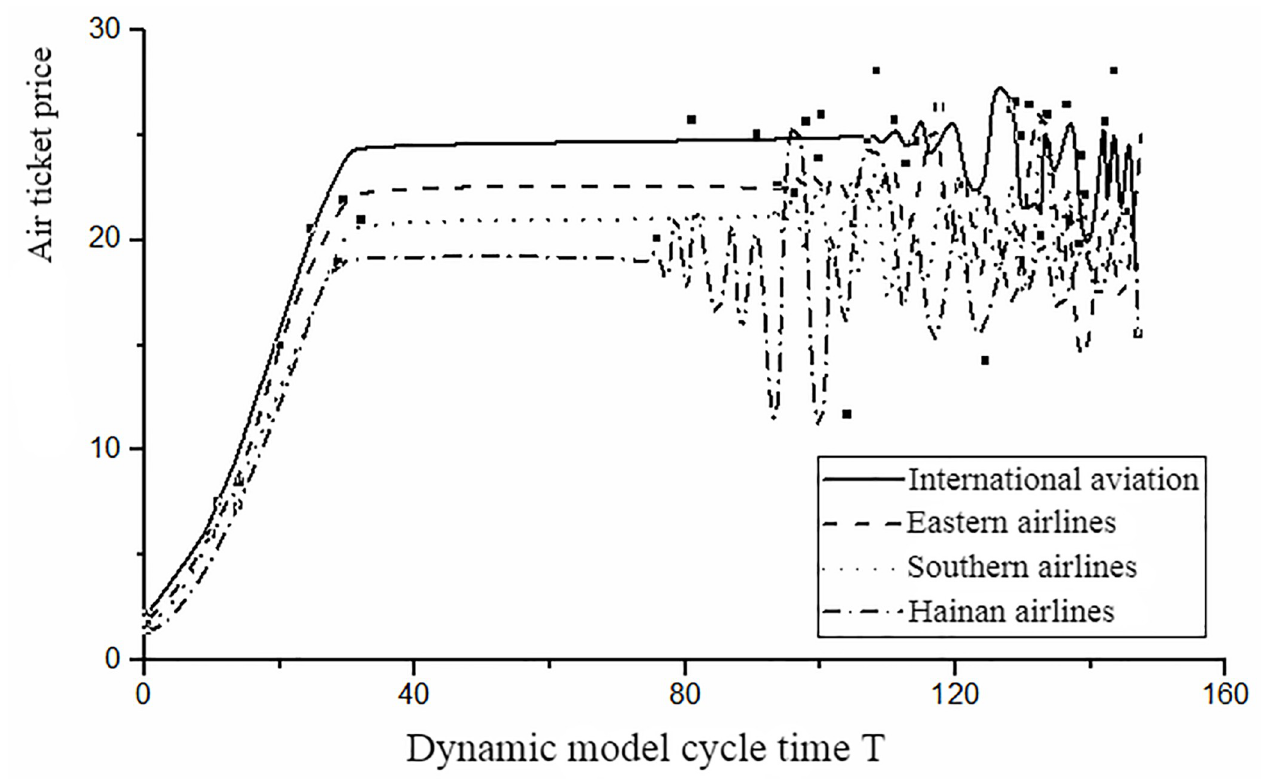
Fig 5. Airline price dynamic competition curve.